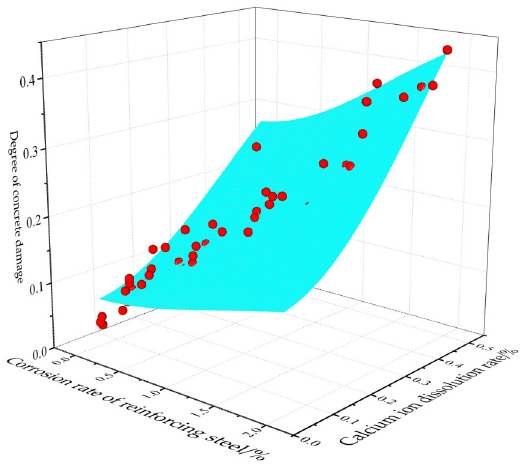
Figure 9. Three-dimensional surface diagram.